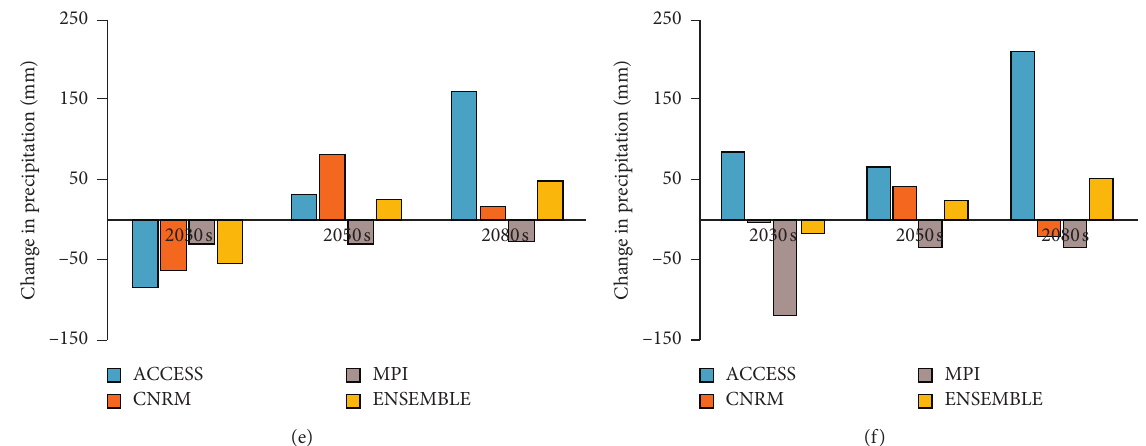
max under RCP4.5. (b) For T max under RCP8.5. (c) For T min